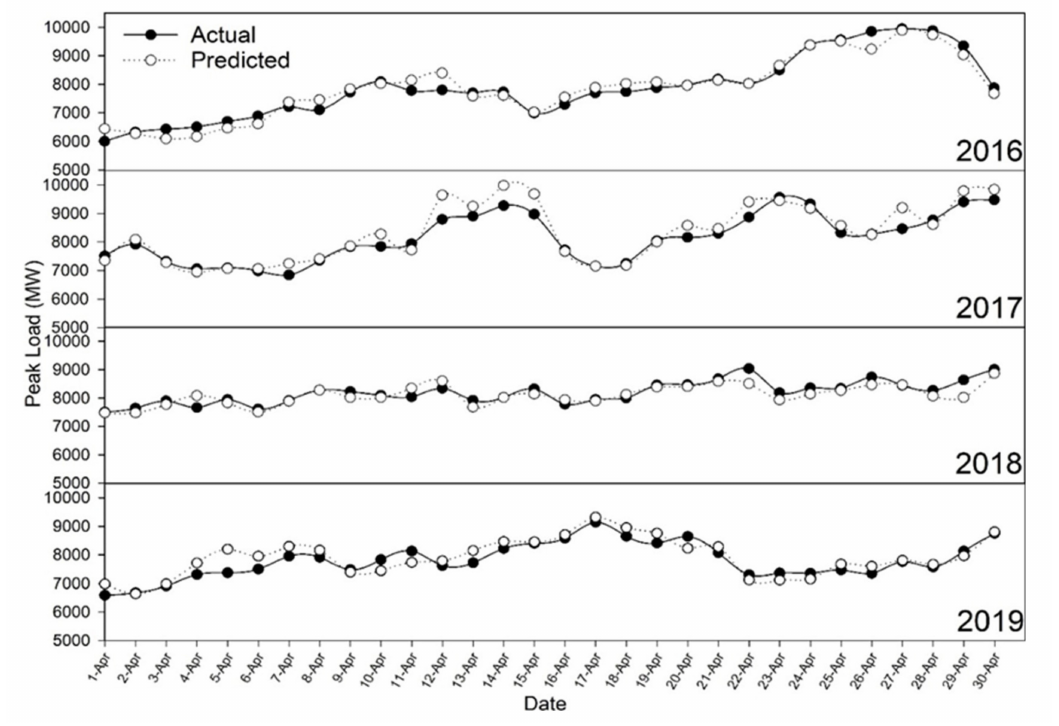
Figure 3. Daily peak load comparison obtained through regression analysis and actual data recorded over four consecutive years.